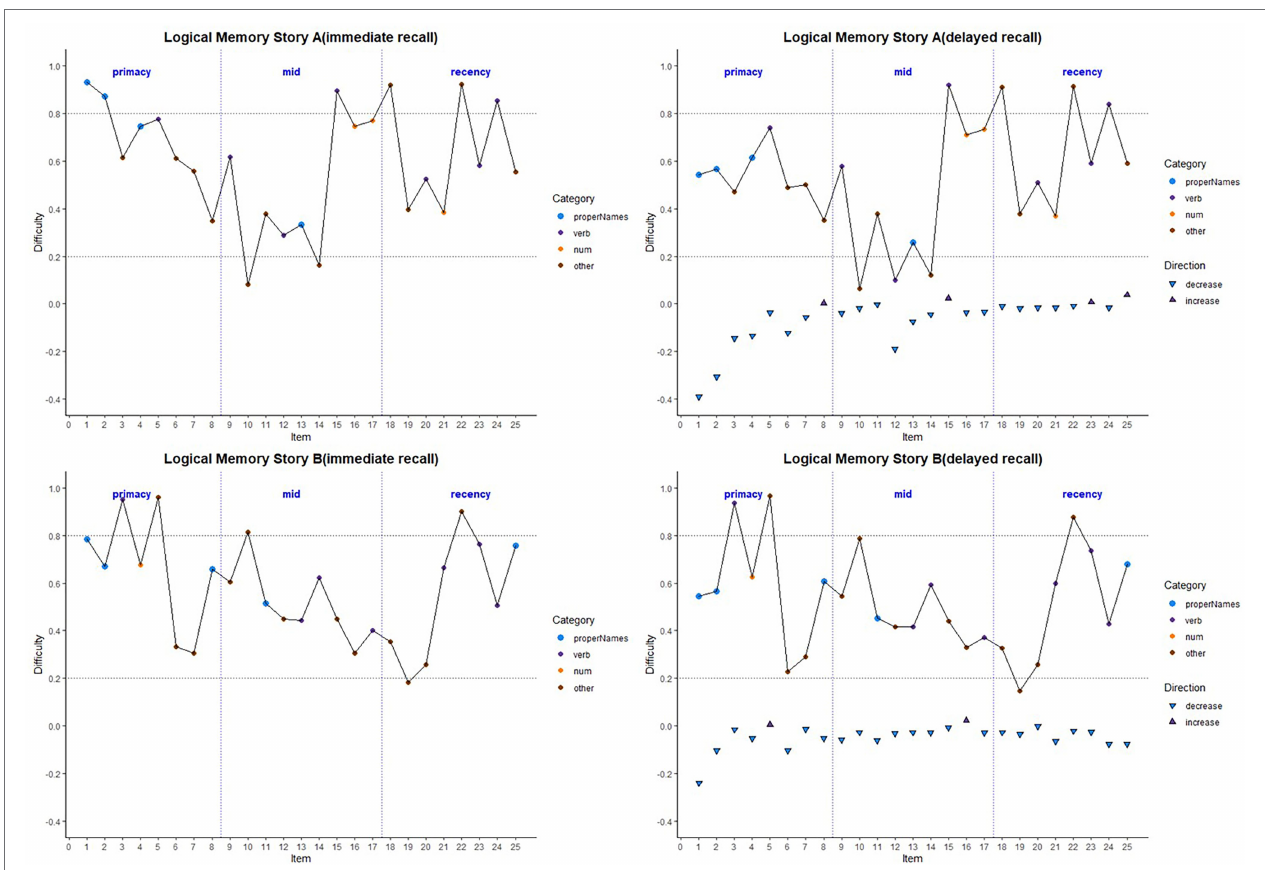
FIGURE 2 | Item difficulty plots (averaged across visits) according to the serial position (primacy, mid, and recency) as well as the lexical category of the items, by story A and story B. Across the primacy, mid, and recency positions, proper name recall shows a drop in percent correct (increase in difficulty) for both story A and story B. The triangles in the right-hand panels are the mean delayed condition percent correct minus mean immediate percent correct for story A and story B. The horizontal dashed lines are desirable difficulty values (between 0.2 and 0.8). Supplementary Figure S1 shows item difficulties by visit, revealing a consistent pattern across all study